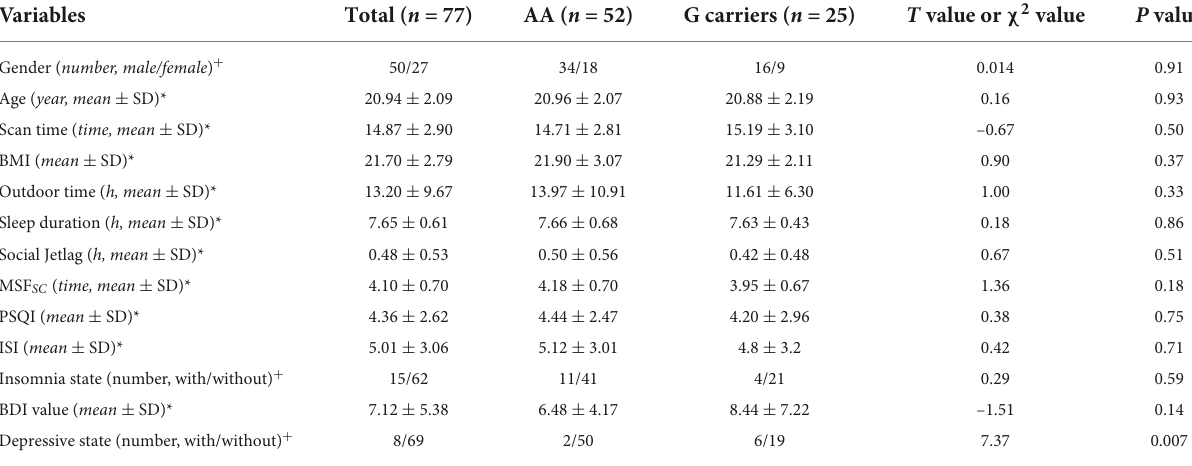
of CC, left anterior limb of internal capsule (ALIC), left retrolenticular part of internal capsule (RLIC), right superior